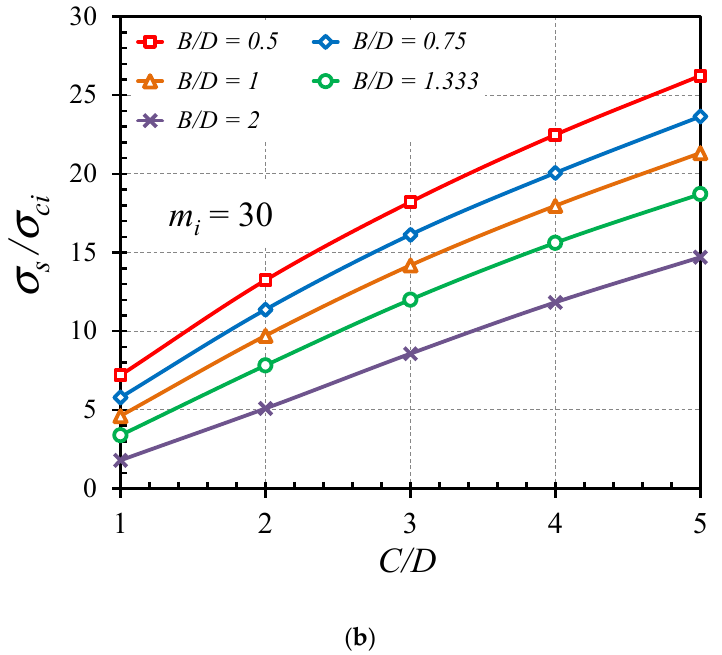
Figure 7. Impact of C / D on σ s / σ ci of horseshoe tunnels with σ ci / γ D = 1000 and GSI = 80: ( a ) m i = 5 and ( b ) m i = 30.